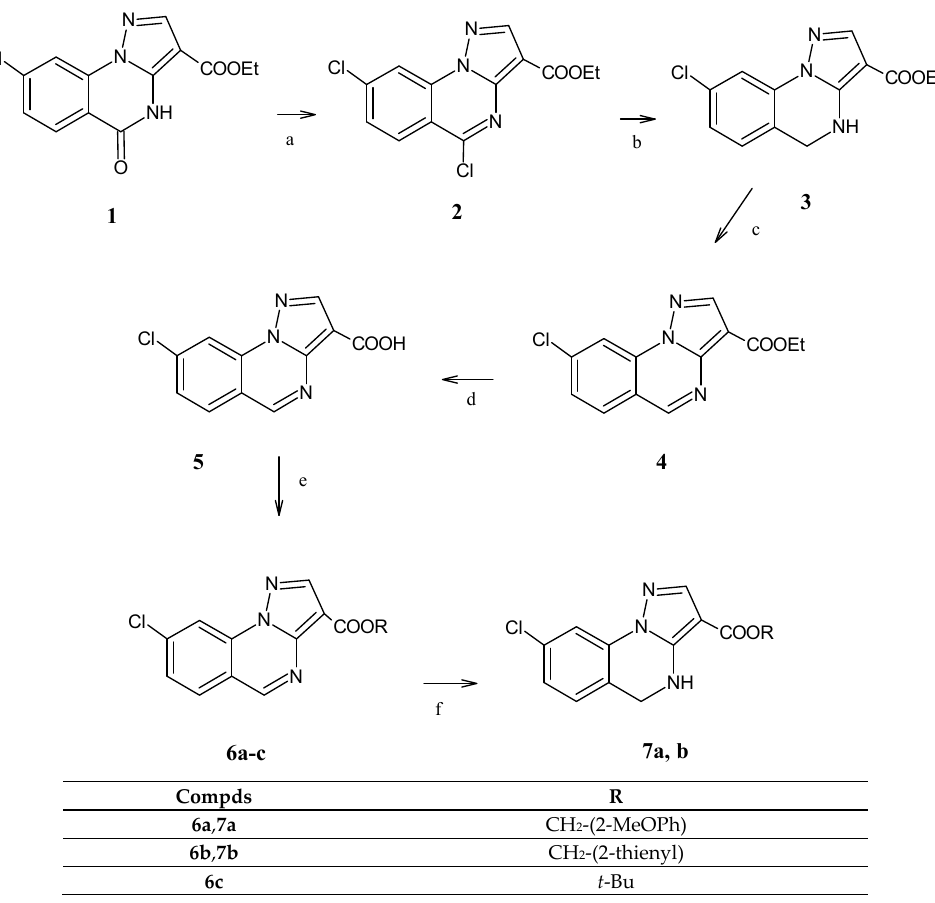
Scheme 1. Reagents and conditions: (a) POCl 3 /PCl 5 , reflux temperature; (b) NaBH 4 , CH 2 Cl 2 /EtOH abs., r.t.; (c) Toluene, Pd/C 10%, reflux temperature; (d) 15% NaOH solution, 80 °C then HCl;